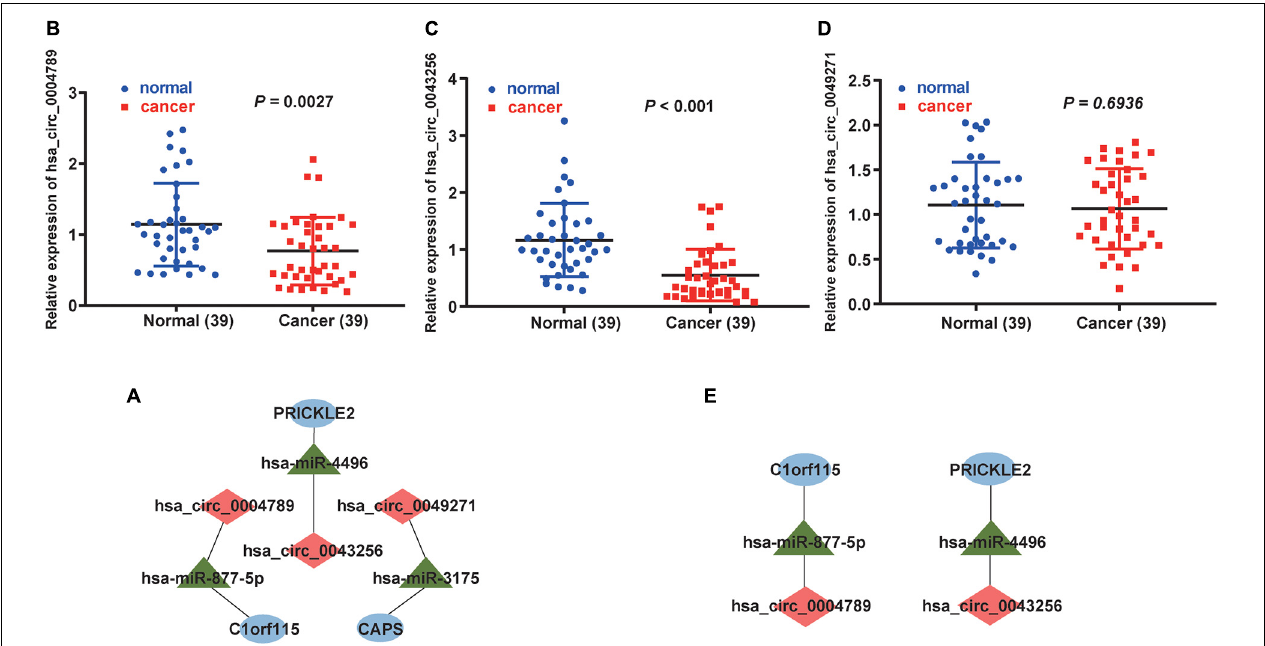
FIGURE 8 | Construction of the final ceRNA hub regulatory network. (A) Construction of the ceRNA hub regulatory network based on the mRNAs associated with LUAD prognosis. As shown in (B–D) , expression of hsa_circ_0004789, hsa_circ_0043256, and hsa_circ_0049271 in 39 LUAD tissues and corresponding non-tumor tissues were detected by qRT-PCR, respectively ( p = 0.0027, p < 0.001, and p = 0.6936). (E) After qRT-PCR verification, the final ceRNA hub regulatory network was constructed. In the ceRNA hub regulatory network, red diamonds indicate circRNAs, green triangles indicate miRNAs, and blue ovals indicate mRNAs.